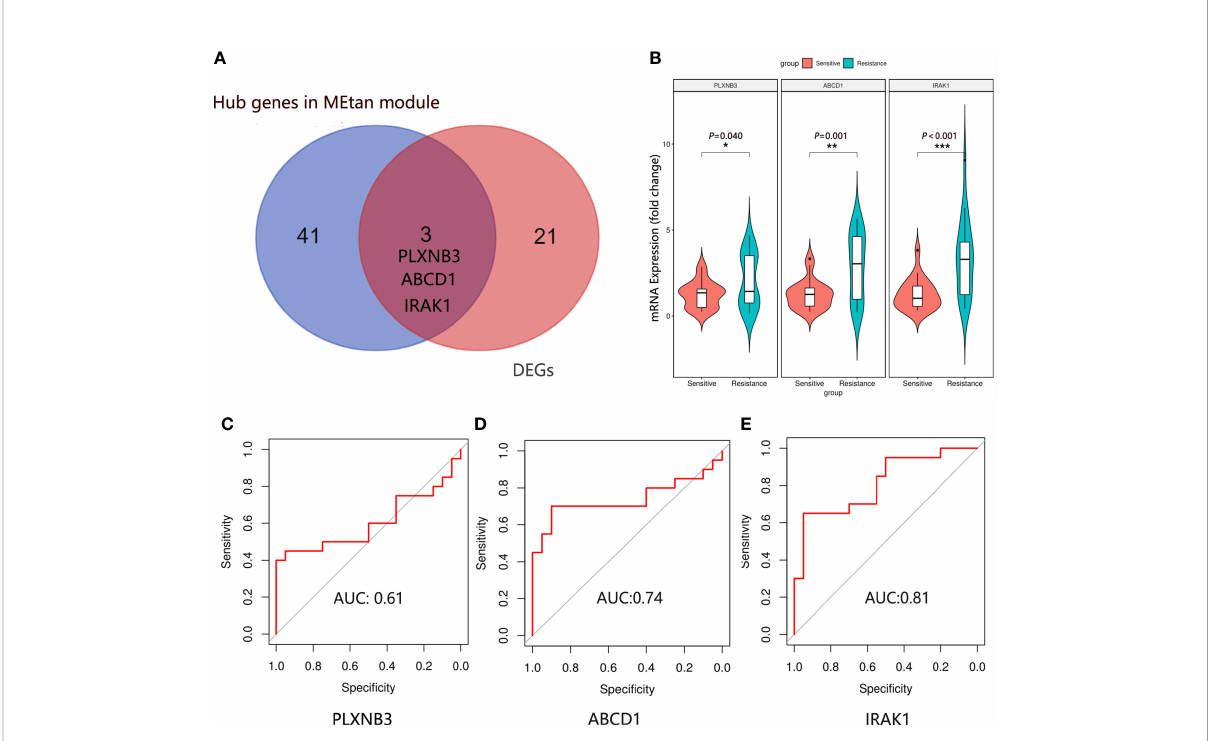
FIGURE 4 Hub gene identi fi cation and validation. (A) The fi nal hub genes were determined by Venn diagram. (B) Expression of IRAK1, ABCD1 and PLXNB3 mRNA in the plasma exosomes in the sensitive group (n=20) and resistance group (n=20). Mean ± SEM, *P < 0.05, **P < 0.01, ***P < 0.001. The ROC curve of IRAK1 (C) , ABCD1 (D) and PLXNB3 (E) in predicting the RASi response in